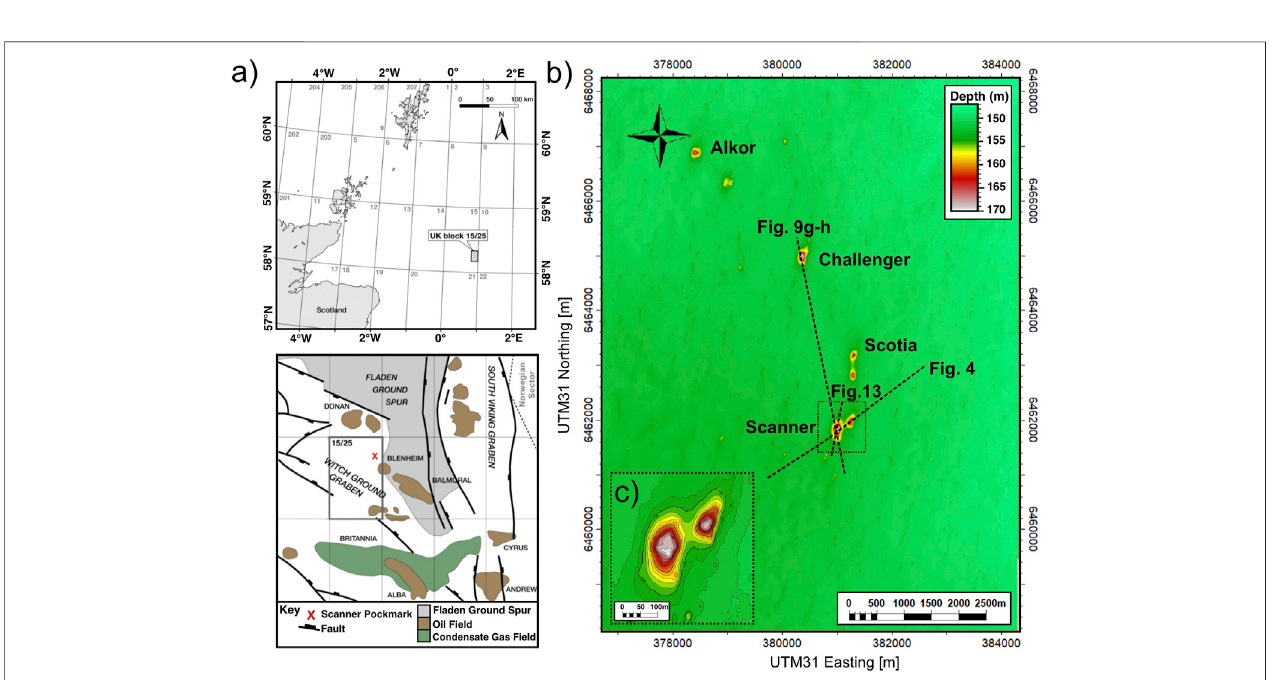
FIGURE 2 | (A) Position of the Scanner Pockmark within the UK Sector of the North Sea. (B) Bathymetric map of the Scanner Pockmark Complex. Dashed lines highlight seismic lines used in Figures 4 , 9G,H . Dotted square box shows inset (C) . (C) Scanner pockmark, displaying East and West Scanner.